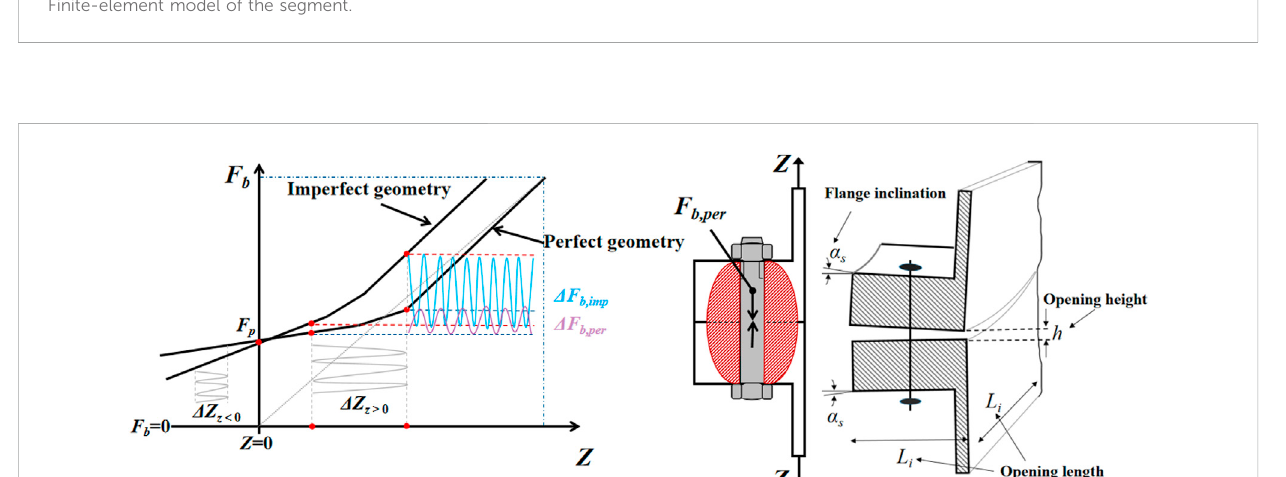
FIGURE 7 Schematic illustration of the load transfer function under perfect and imperfect geometrical fl ange conditions (left); centric clamp solid due to the preload depicted in red (middle); and the detailed con fi guration of fl atness divergence (right).